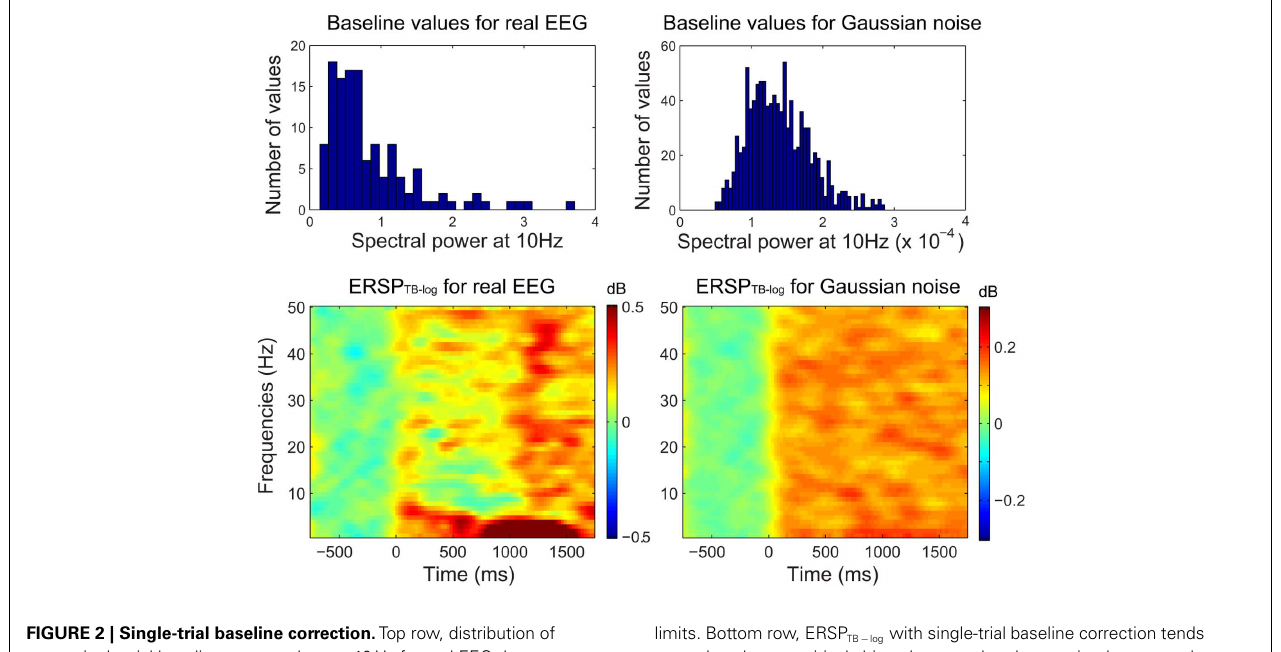
FIGURE 2 | Single-trial baseline correction. Top row, distribution of mean single-trial baseline power values at 10Hz for real EEG data (electrode Iz of subject “CLM” – see Materials and Methods) and for 1000 simulated trials of normalized Gaussian noise with the same time